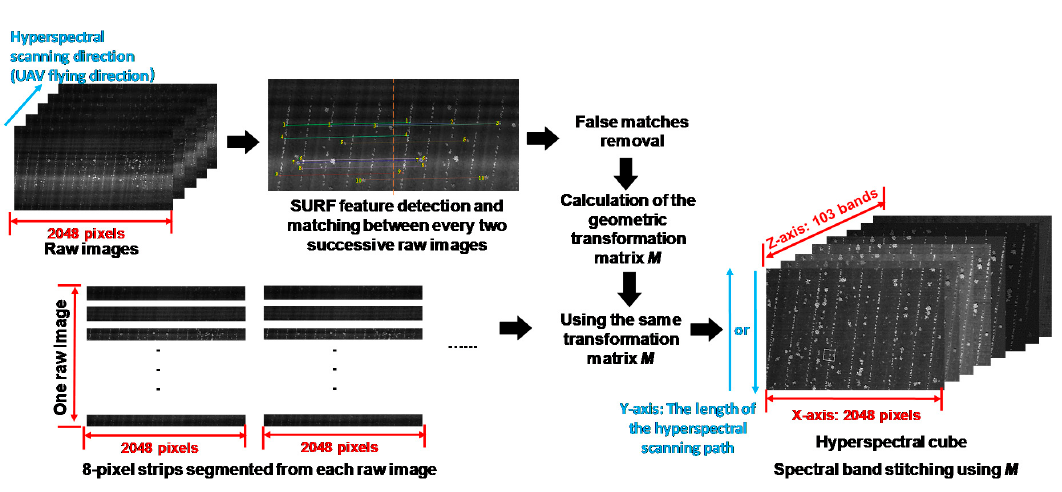
Figure 3. Workflow of the spectral band stitching process.